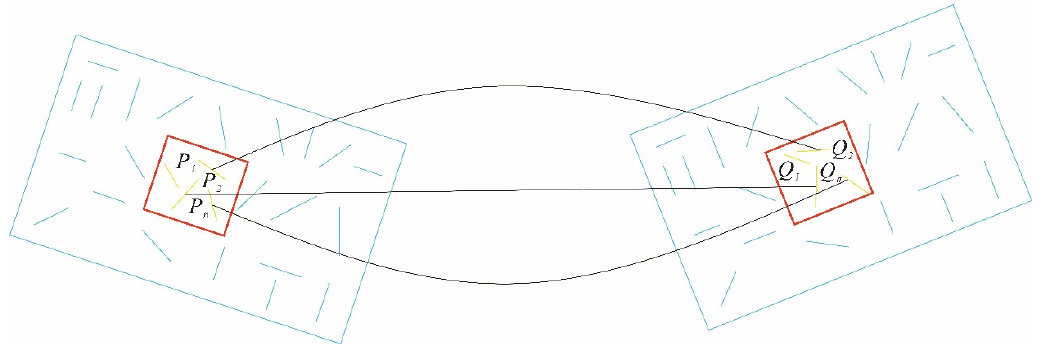
Figure 3. Using geometric information to match line features. The initial matching is performed by the pixel coordinates of the line features. The red box represents the grid divided in the image, and the yellow lines represent the line features that fall into the same grid of the two matching